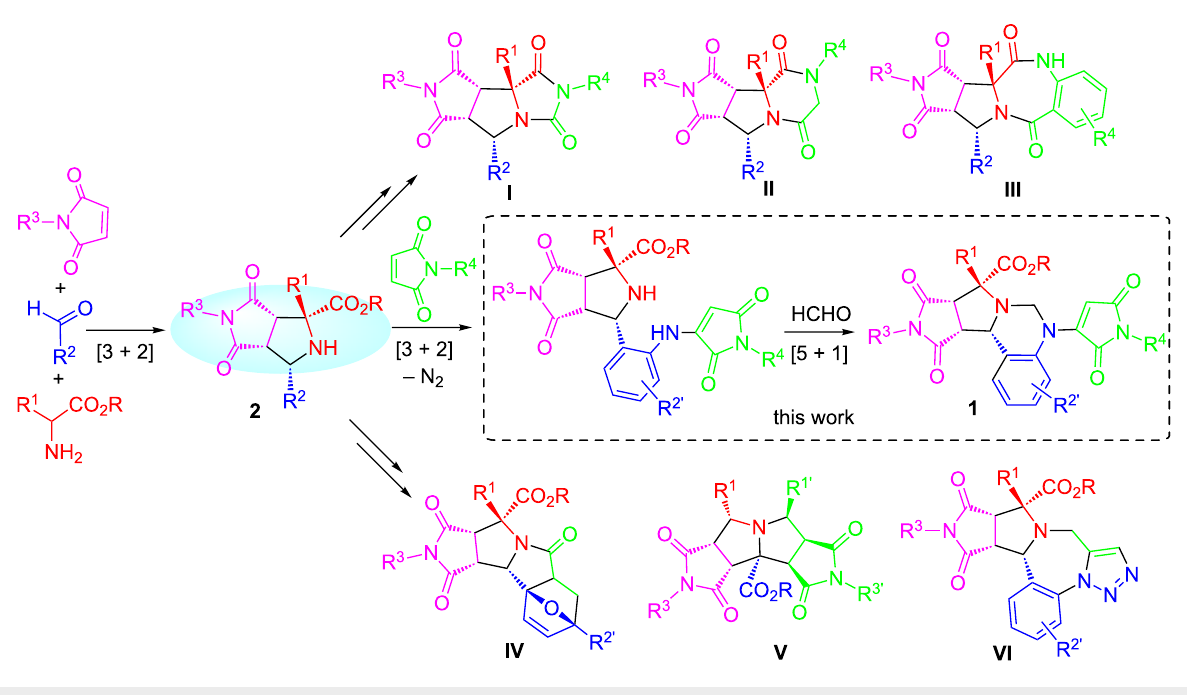
thrombin, potassium channel, mPGES-1, and tubulin inhibitors, as well as the immunomodulatory drug thalidomide [28-32] (Figure